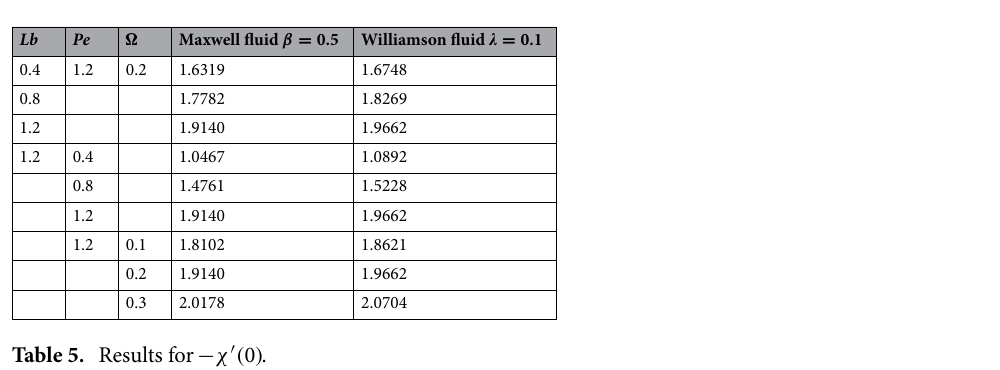
Table 5. Results for